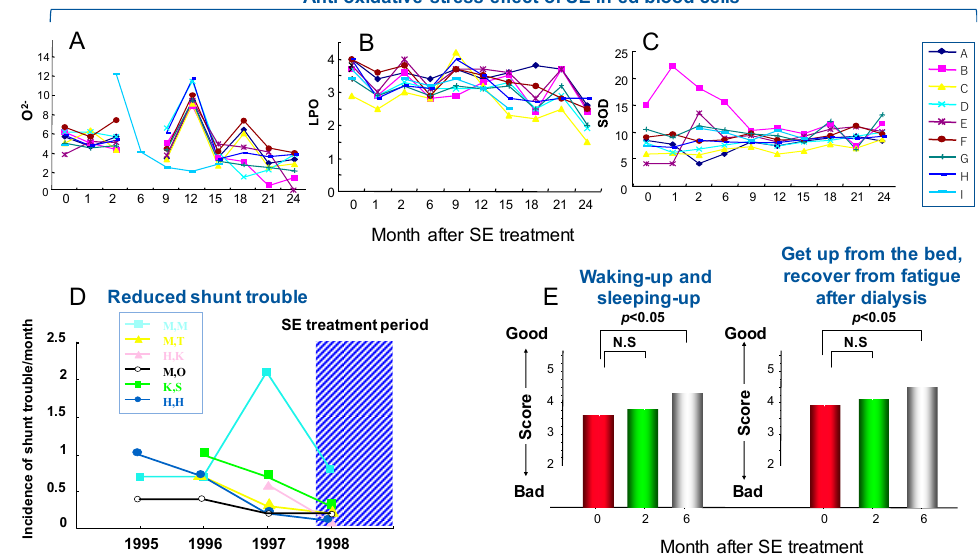
Figure 11. Anti-oxidative stress effects on chronic dialysis patients. ( A ) Superoxide (O 2- ) (measured by luciferin chemiluminescence method), ( B ) LPO (measured by HPLC), ( C ) SOD activity (xanthine · xanthine oxidase reaction) of red blood cells. ( D ) Incidence of shunt problem from 1996–1998. Patients were treated with SE after 1 November 1997. ( E ) Questionnaire about the clinical effect of SE. Cited from Reference [108] with permission.